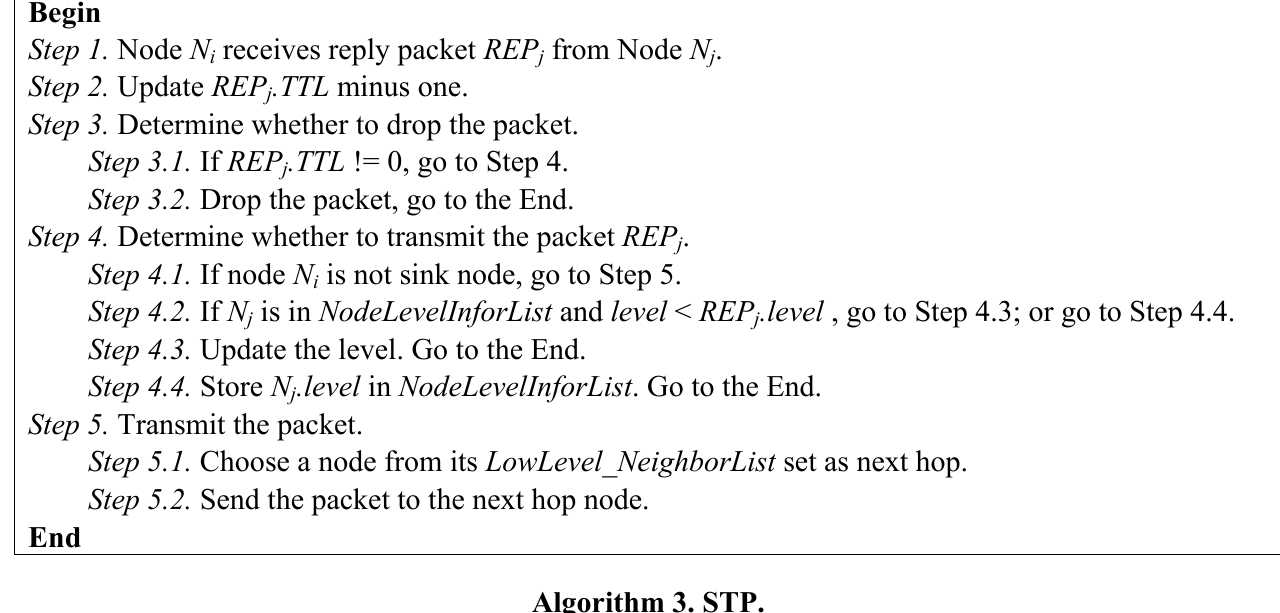
Algorithm 2. LIB.